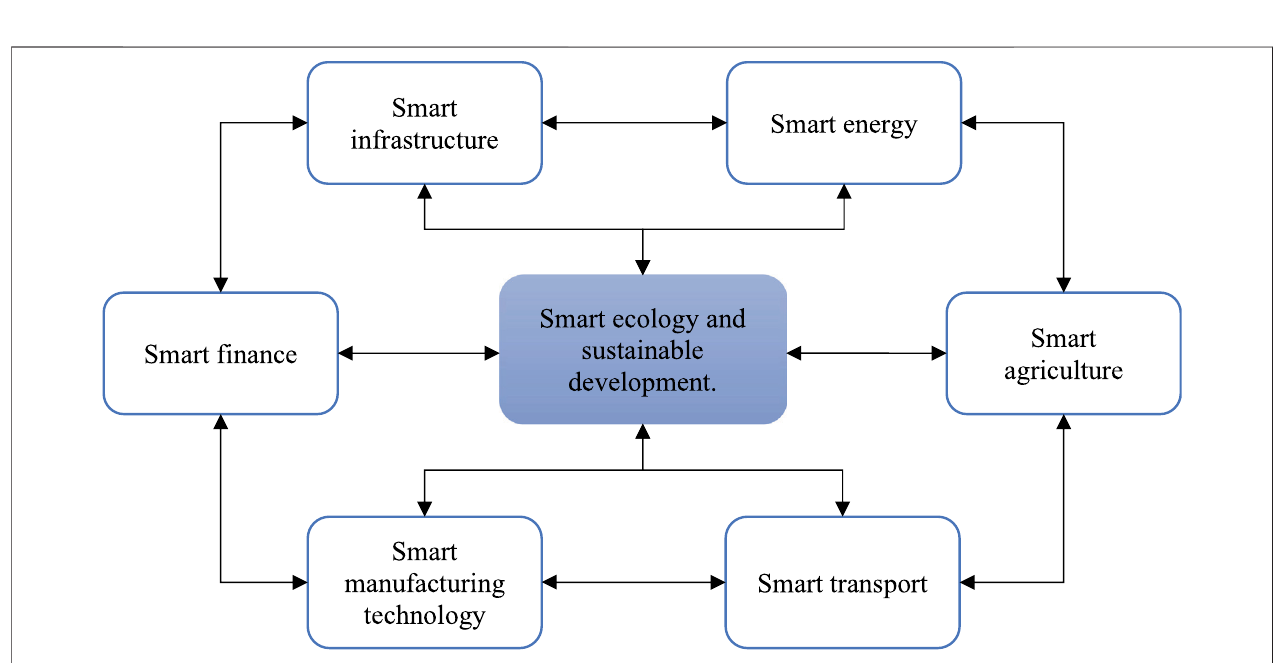
FIGURE 2 | The main directions of solving the problems of sustainable development of enterprises in a smart ecology (Open School of Business, 2016; Investlab, 2020).